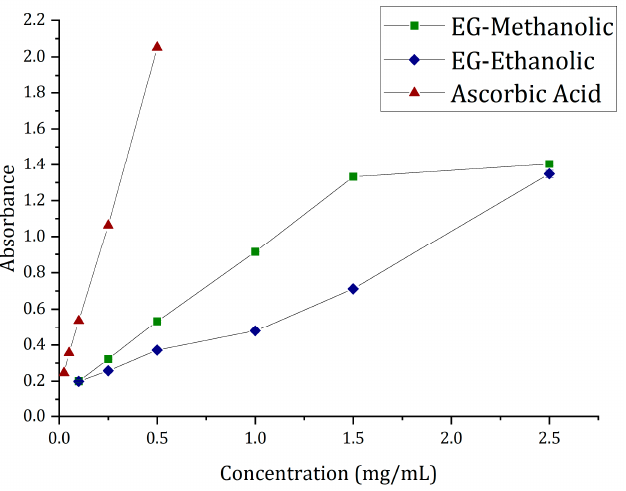
Figure 6. Ferric reducing power results comparison of plant extract and standard.